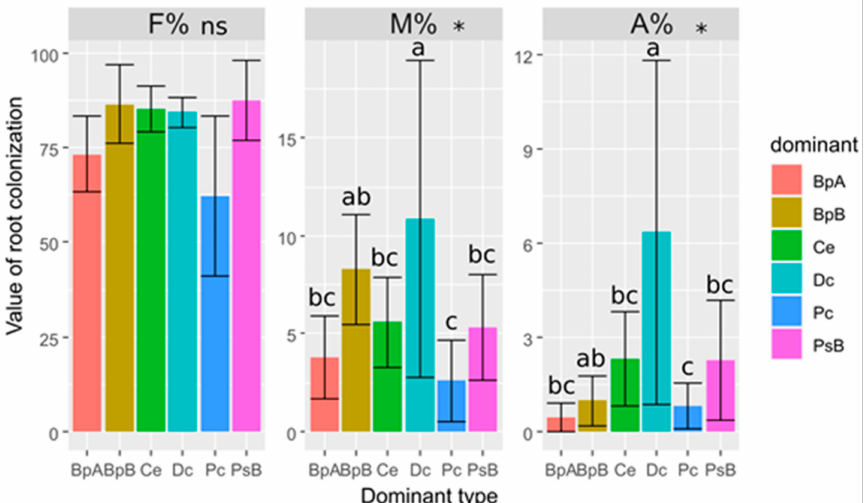
Figure 2. The mycorrhizal parameters (Mean ± SE) in the root system of Calamagrostis epigejos in the vegetation patches dominated by Pc— Poa compressa , Ce— Calamagrostis epigejos , Dc— Daucus carota , BpB— Betula pendula shrub, BpA— Betula pendula tree, and PsB—Pinus sylvestris shrub. Results of ANOVA: ns—non-significant, * p < 0.05. The various letters above bars denote significance of differences at p < 0.05 after LSD test.